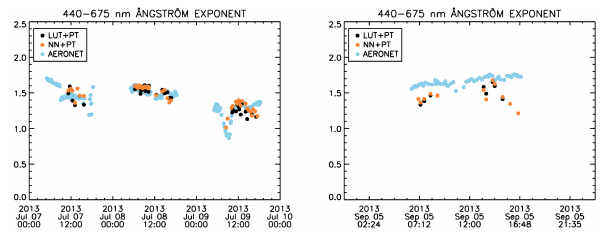
Figure 9. Time series of the 440–670nm Ångström exponent re- trieved by the LUT + PT scheme (black circles), the NN + PT scheme (orange circles), and the AERONET direct sun level 1.5 product (sky-blue circles): between 7 and 9 July 2013 (left) and on 5 September 2013 (right).